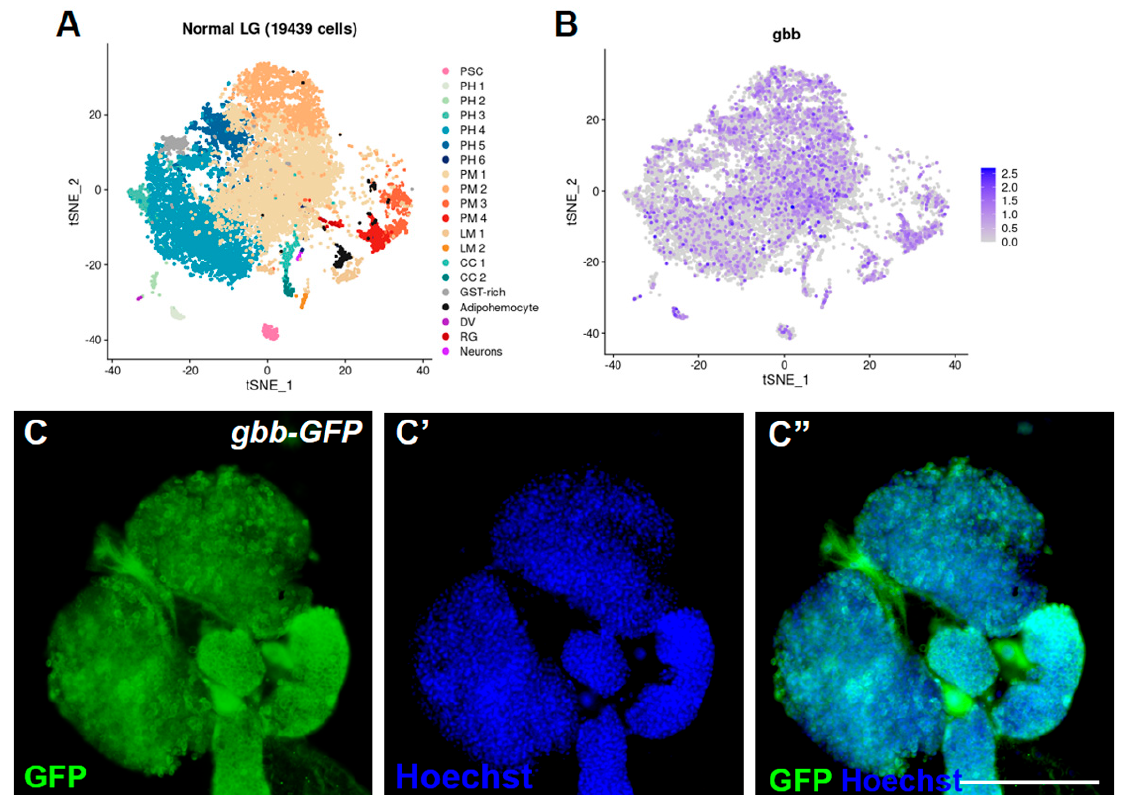
Figure 1. Gbb is widely expressed in the Drosophila lymph gland. ( A ) The t − SNE plot shows the two − dimensional projection of major cell type subclusters identified in the scRNA − seq of normal 120 h AEL (after egg laying) lymph glands. ( B ) Relative expression level of gbb selected in scRNA − seq of normal 120 h AEL lymph gland dataset corresponding to the t − SNE plot in A. ( C – C ″ ) Immunostaining against GFP shows that Gbb is expressed in the entire lymph gland. Scale bars: 100 μ m ( C – C ″ ).